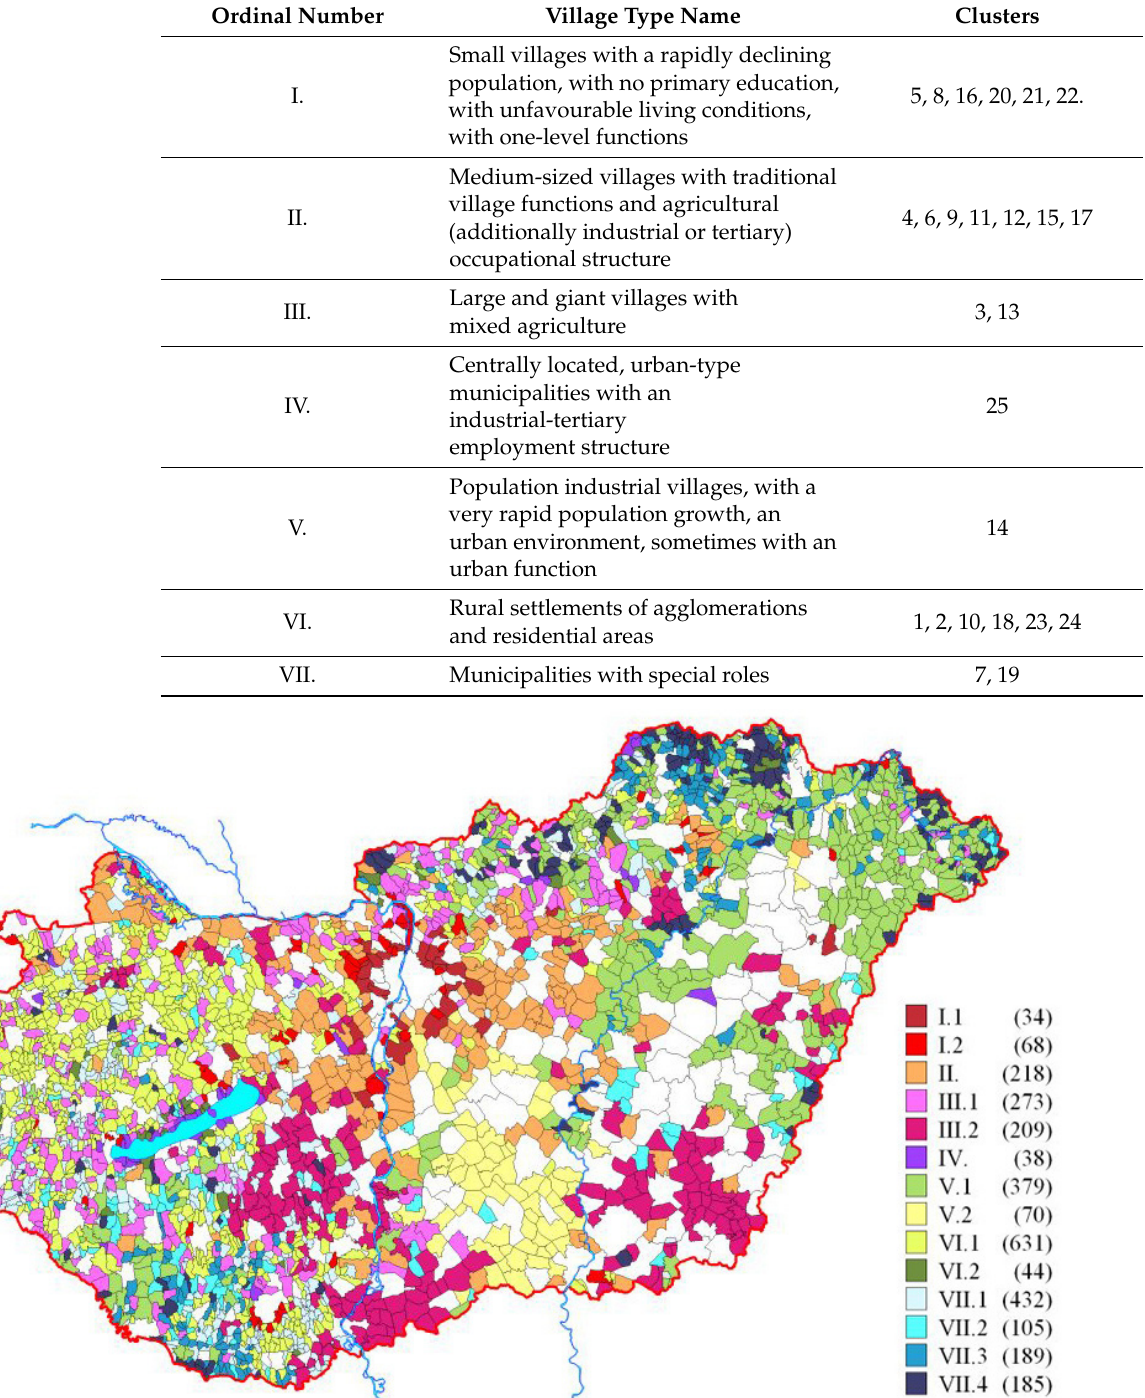
Figure 6. Village types in Hungary, 2007 [21].